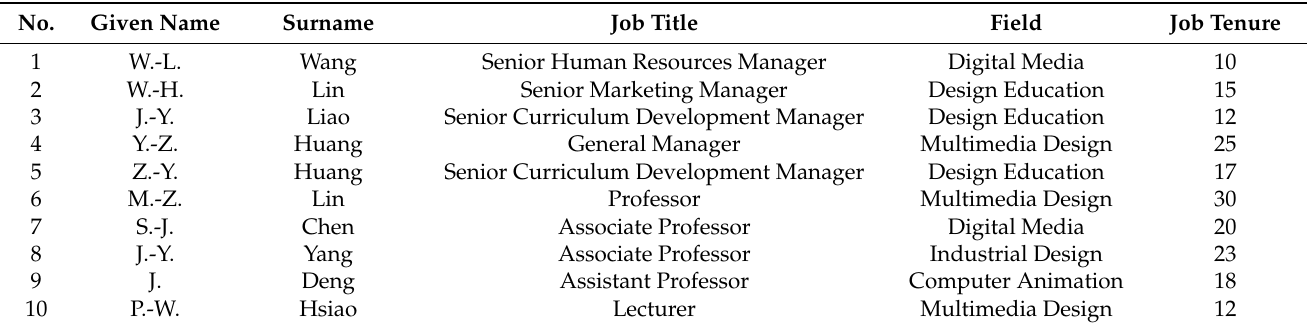
Table 3. The information about 10 experts.